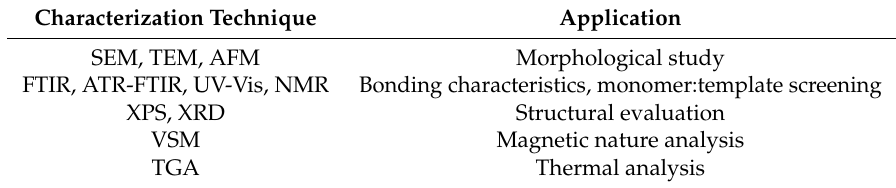
Table 1. Characterization methods and the information sought for the MIP formation